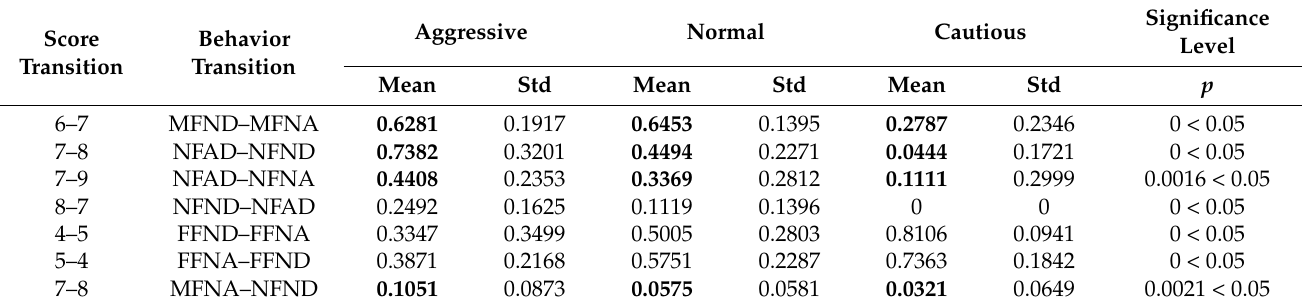
Table 4. Significance analysis of driving behavior transition probability of different driving styles.